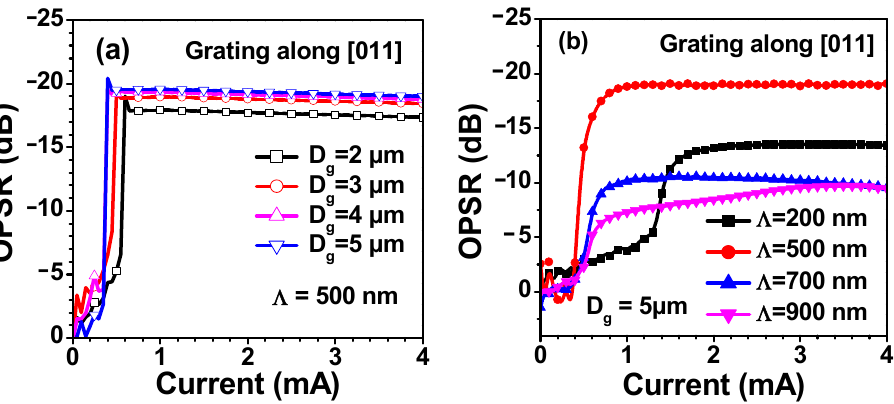
Figure 5. ( a ) OPSR of VCSELs for different surface grating areas with a period of Λ = 500 nm. ( b ) OPSR of VCSELs with different grating periods at D g = 5 μ m.